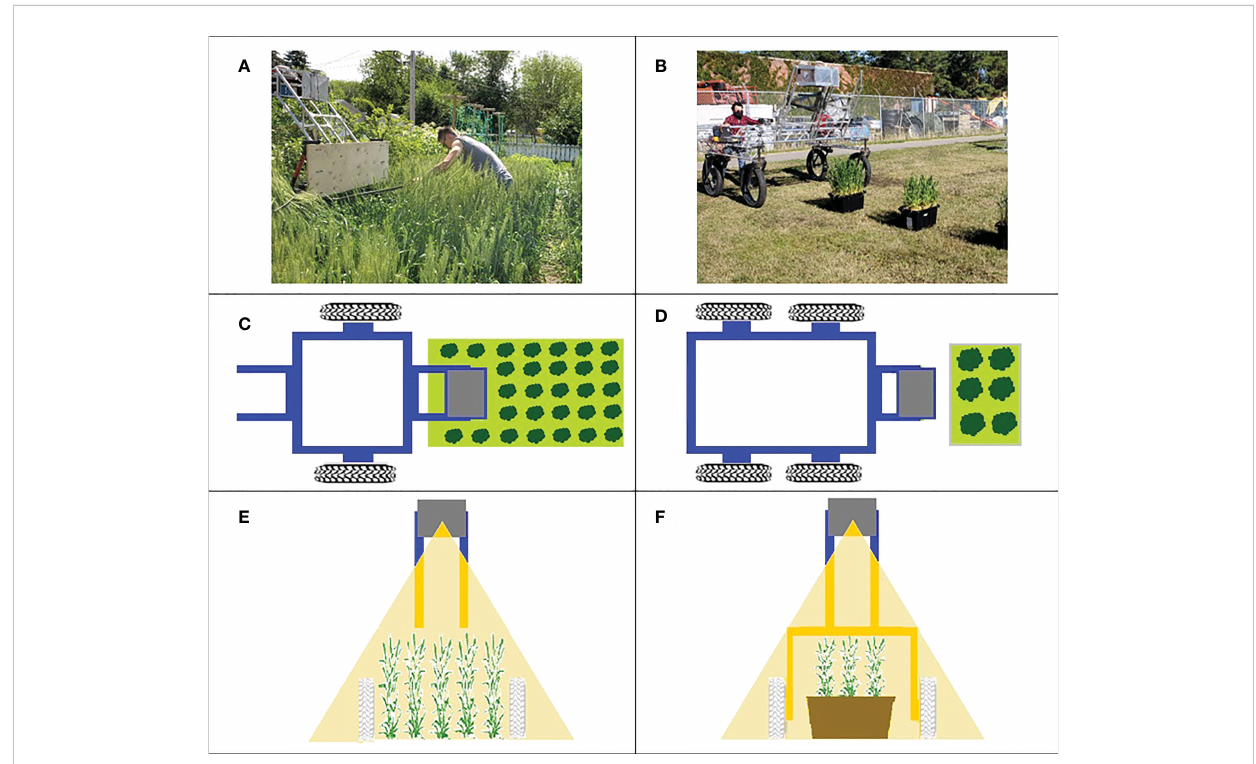
FIGURE 1 Data acquisition platform. Left column (A, C, E) shows the system used in 2019 experiment, right column (B, D, F) shows the 2020 system. Top row: photographs of the systems in use. Middle row: a top view diagram of data acquisition for the year. Bottom row: Front view showing the plane of the LiDAR